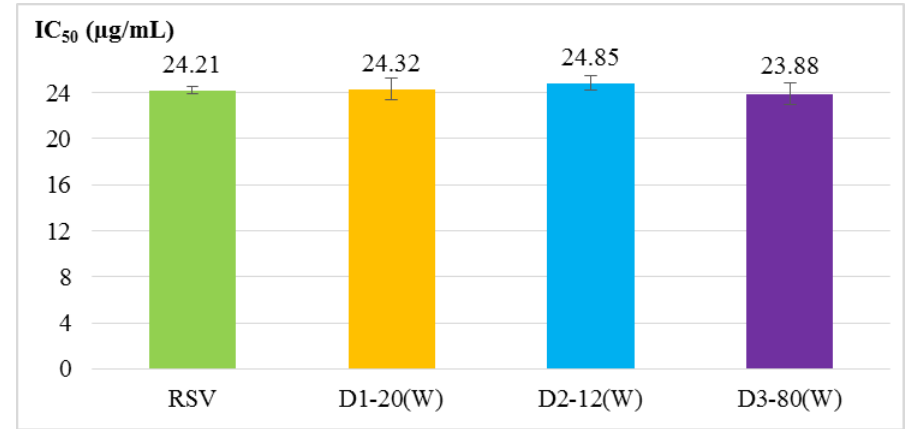
Figure 2. ABTS + radical scavenging activity of RSV and RSV transfersomes (D1–20(W), D2–12(W), and D3–80(W) groups). The IC 50 value is the sample to remove the 50% ABTS + radical cations (7 × 10 −3 M) required concentration. The values are means ± SD.